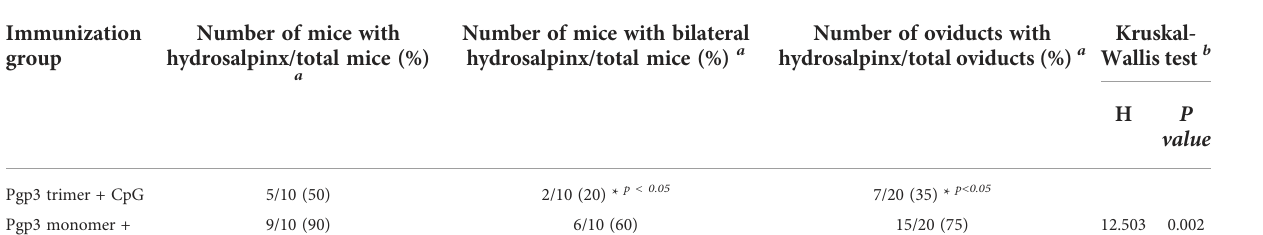
Number of oviducts with hydrosalpinx/total oviducts (%) a